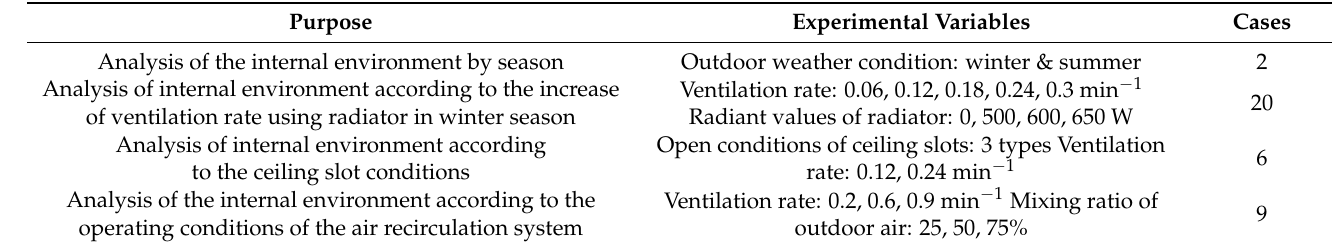
Table 3. Case studies of the CFD simulation in this